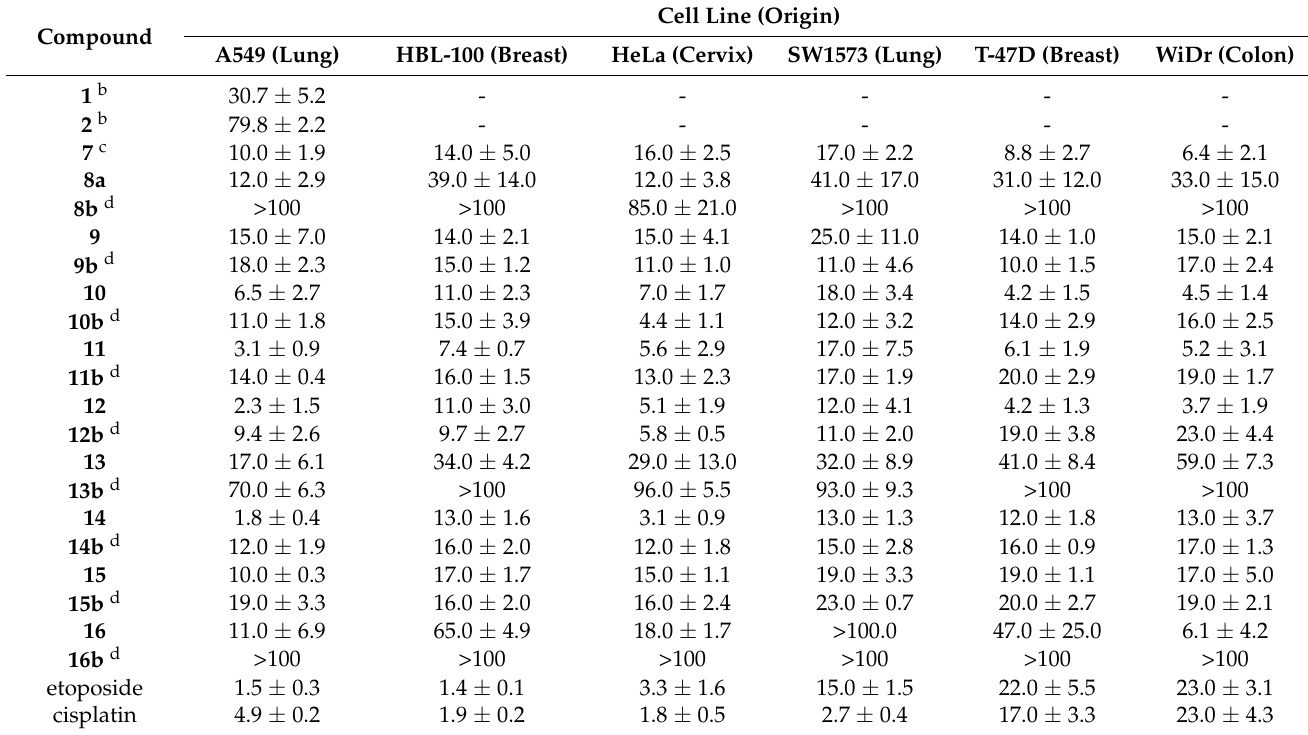
Table 4. Antiproliferative activity (GI 50 ) of 4-epi-liquiditerpenoic acid (8a), and analogs 9–16 against some human solid tumor cells a